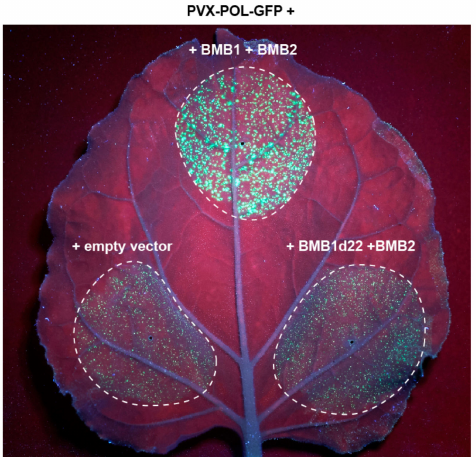
Figure 3. Analysis of functional competence of BMB1d22. Complementation of cell-to-cell movement of PVX-POL-GFP by combinations of BMB1 with BMB2, BMB1d22 and empty vector (negative control) is shown. The leaf was imaged under UV light at 5 d.p.a. Dashed lines encircle infiltrated